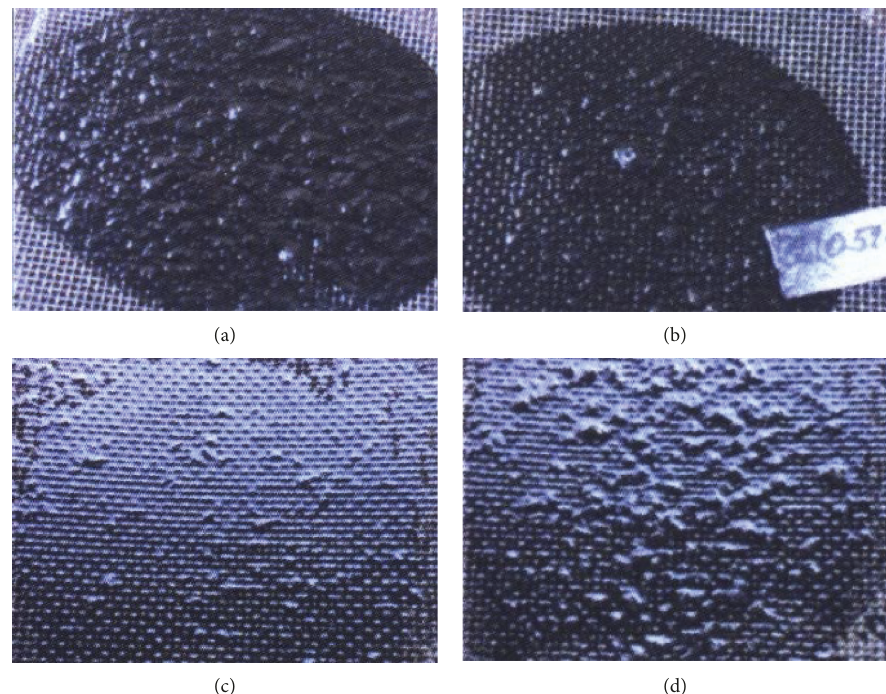
Figure 1: Residues of samples after filtration through a sieve, Φ 0.40 mm. (a) Sample no.1, (b) sample no. 2, (c) sample no. 3, and (d) sample no. 4.